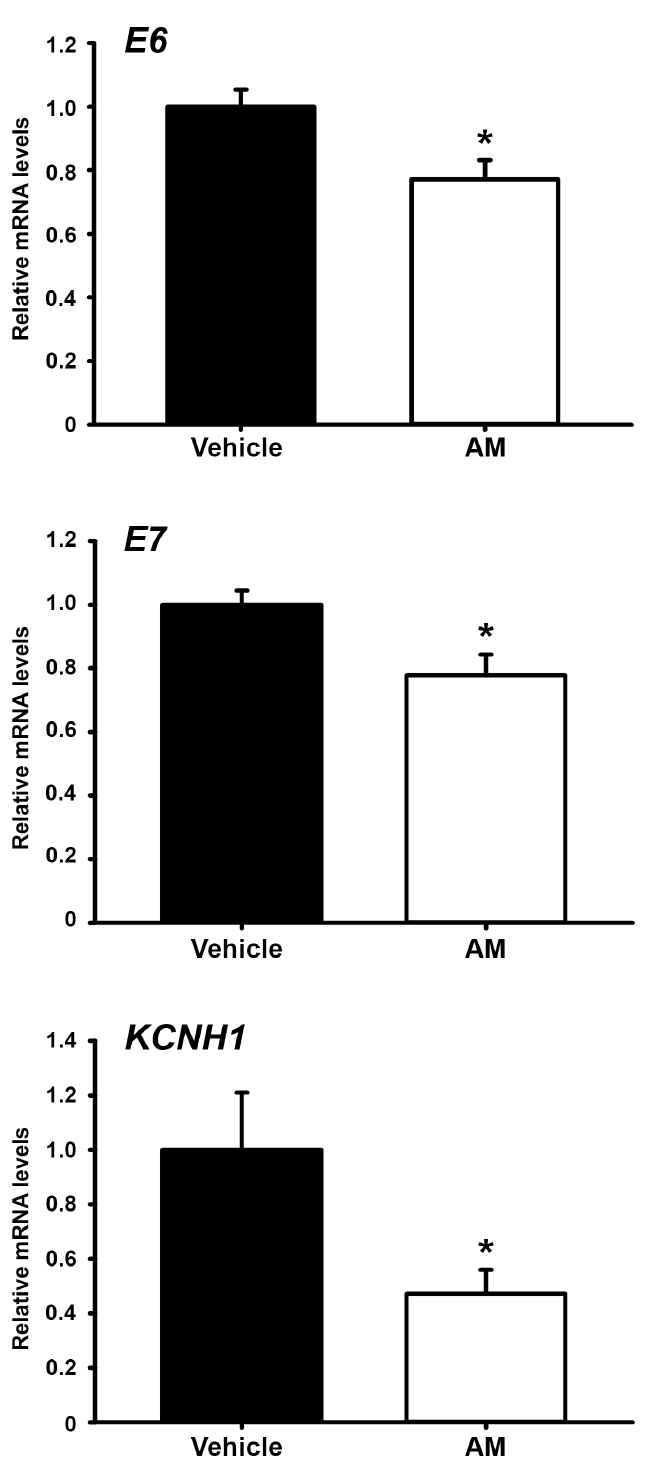
Figure 5. AM decreases E6/E7 -HPV16 oncogenes and KCNH1 tumor gene expression. After four weeks of treatment with vehicle (0.1% DMSO, black bars) or α -mangostin (AM, 8 mg/kg of body weight/day, white bars), the mice were euthanized and the tumor tissue was collected and submitted to RT-qPCR experiments. Gene expression level was normalized against the housekeeping gene RPL32. The results are the mean ± SEM of at least nine tumors per treatment group. * p < 0.05 vs.